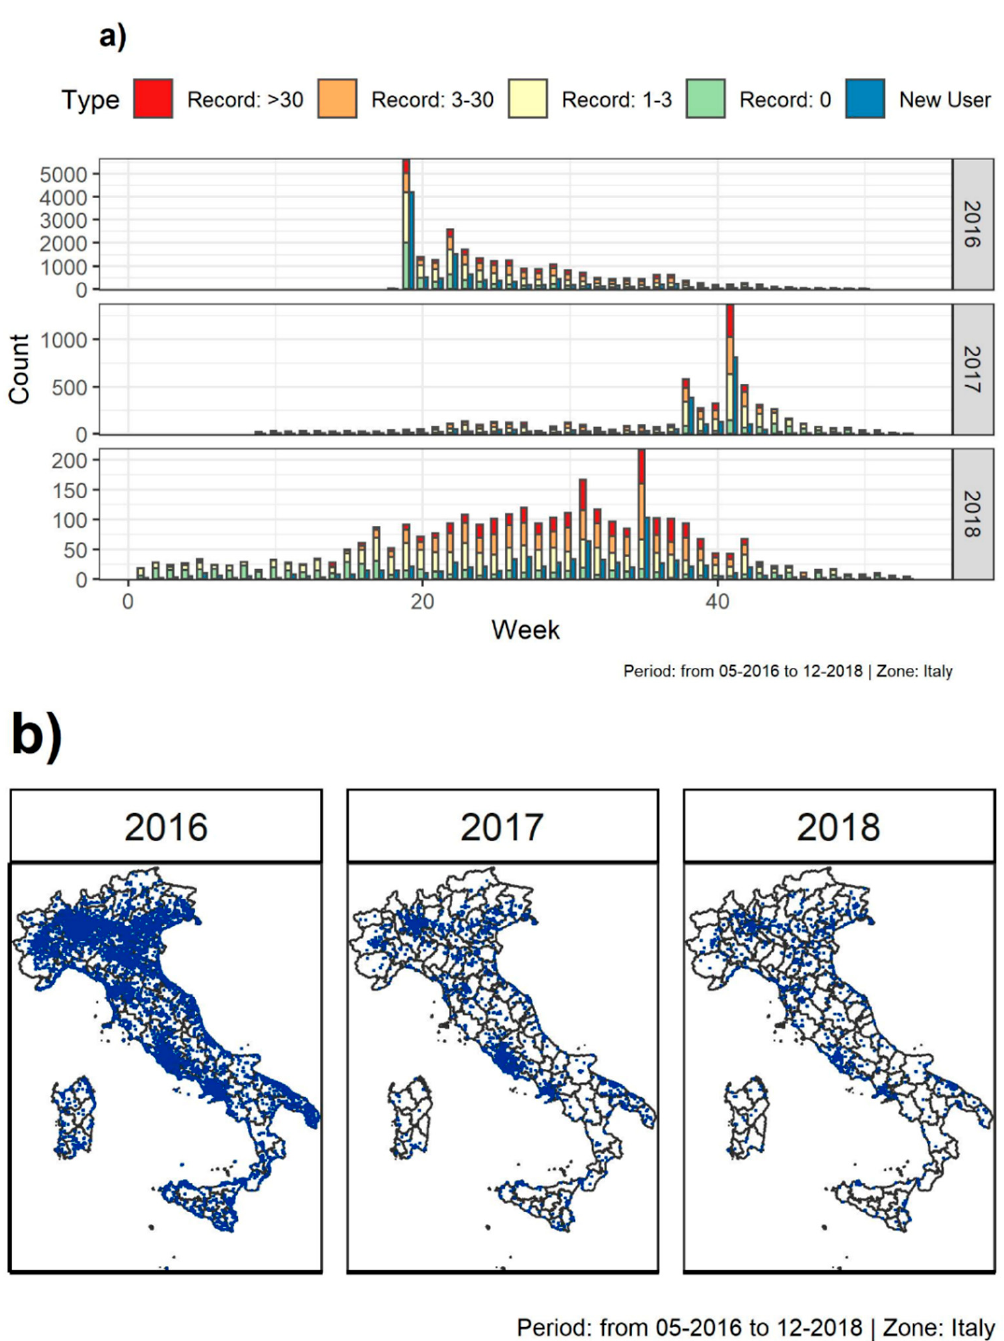
Figure 1. ZanzaMapp records from 2016 to 2018. ( a ) weekly distribution of mosquito abundance categories (0, 1–3, 3–30, > 30, multicolour bars) and new users (blue bars). Range of y-axis varies between panels referring to different years in order to help interpretation; ( b ) spatial distribution.